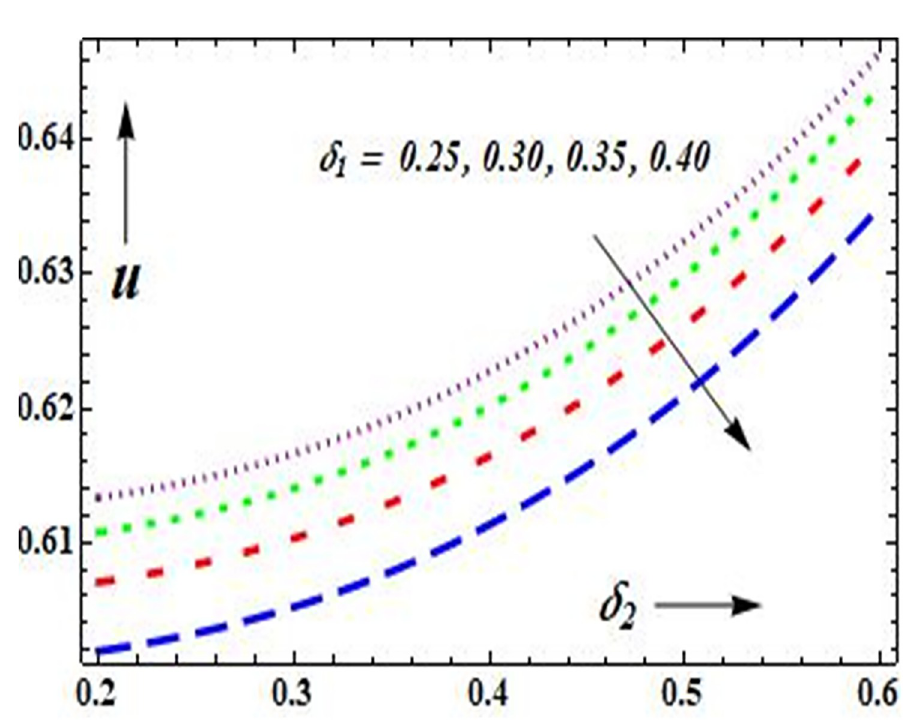
Fig 19. Plot of u on δ 2 and δ 1 with ϕ ¼ π